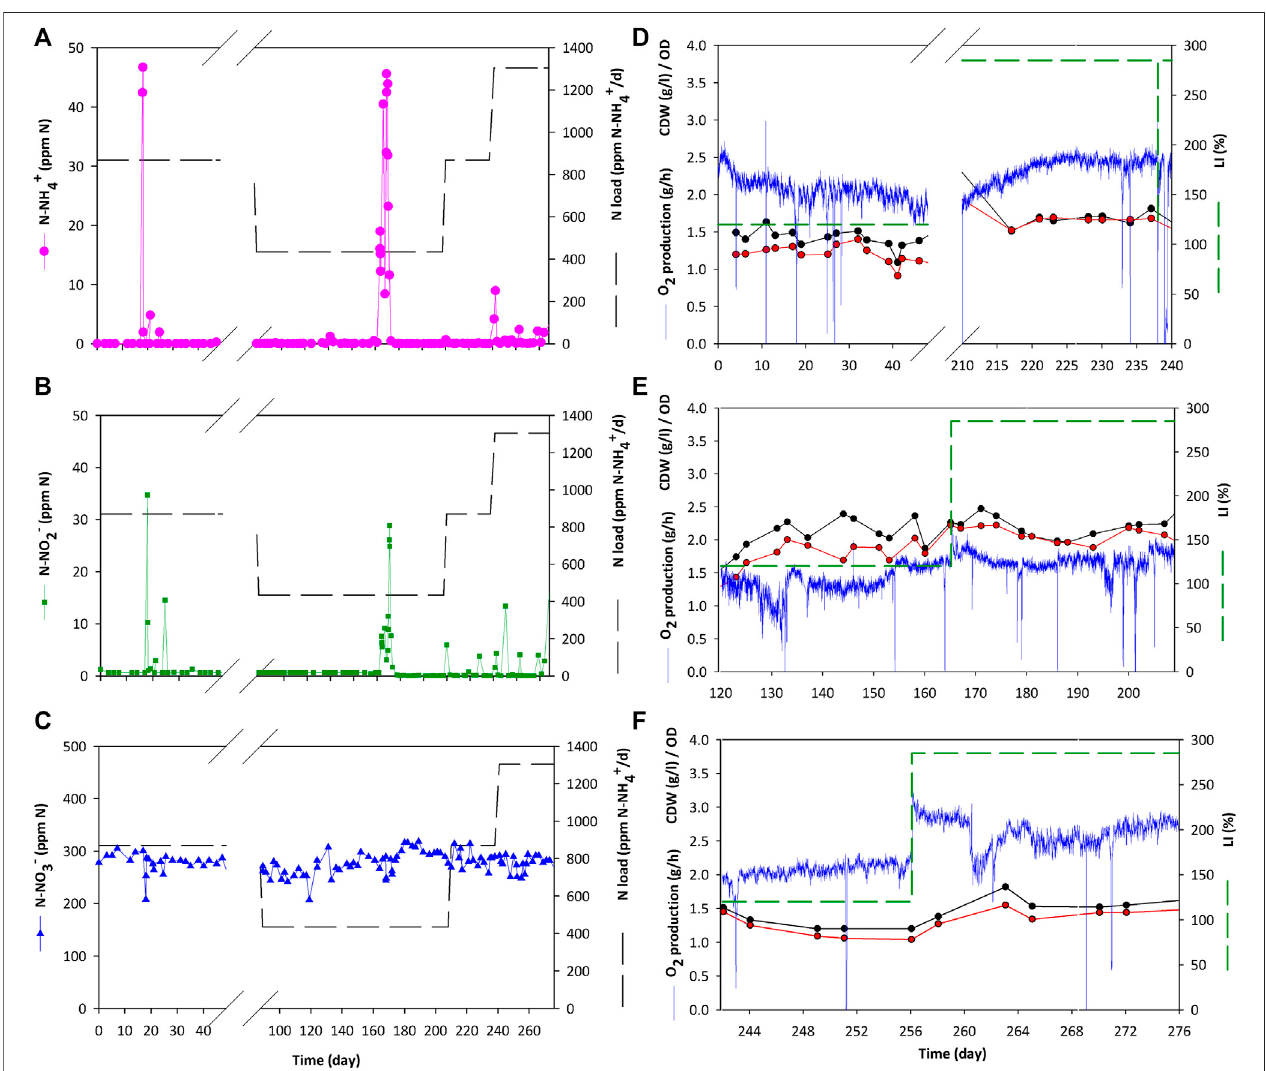
FIGURE 4 | Results for integration experiments between nitrifying and photosynthetic compartment. Panels (A – C) show the nitrogen species at the nitri fi cation bioreactoroutlet.N-NH4+concentrationispresentedindottedpinkpoints.N-NO2-ispresentedinsquaregreenpoints.AndN-NO3-isdisplayedinbluetrianglepoints. Panels (E – F) illustrates the oxygen production and biomass content in the PBR for different combinations of light and liquid fl ow rate [ (D) 20 L · d − 1 ; (E) 10 L · d − 1 ; (F) 30 L · d − 1 ]. Light intensity is presented in dashed green line, O2 production is showed in solid blue lines, biomass related parameters are displayed in black and red dotted points for CDW and OD